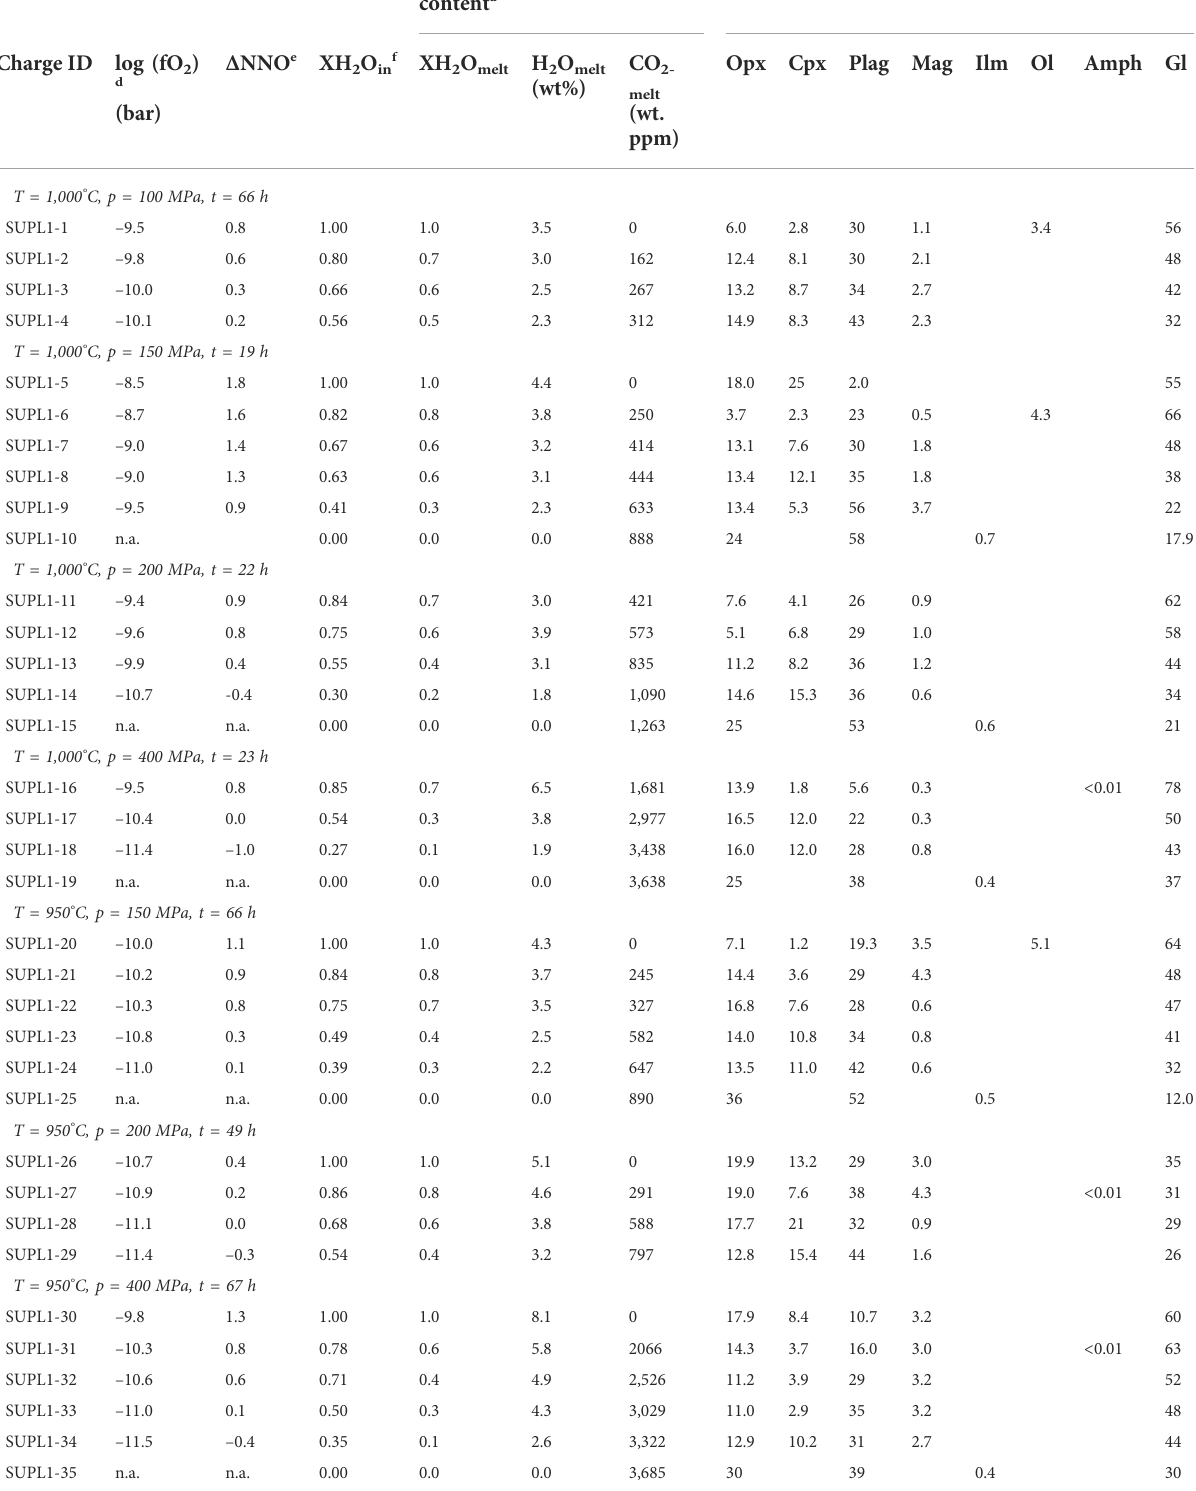
TABLE 5 Summary of experimental conditions, calculated melt volatile contents, and run products and their phase proportions. Calculated melt volatile content